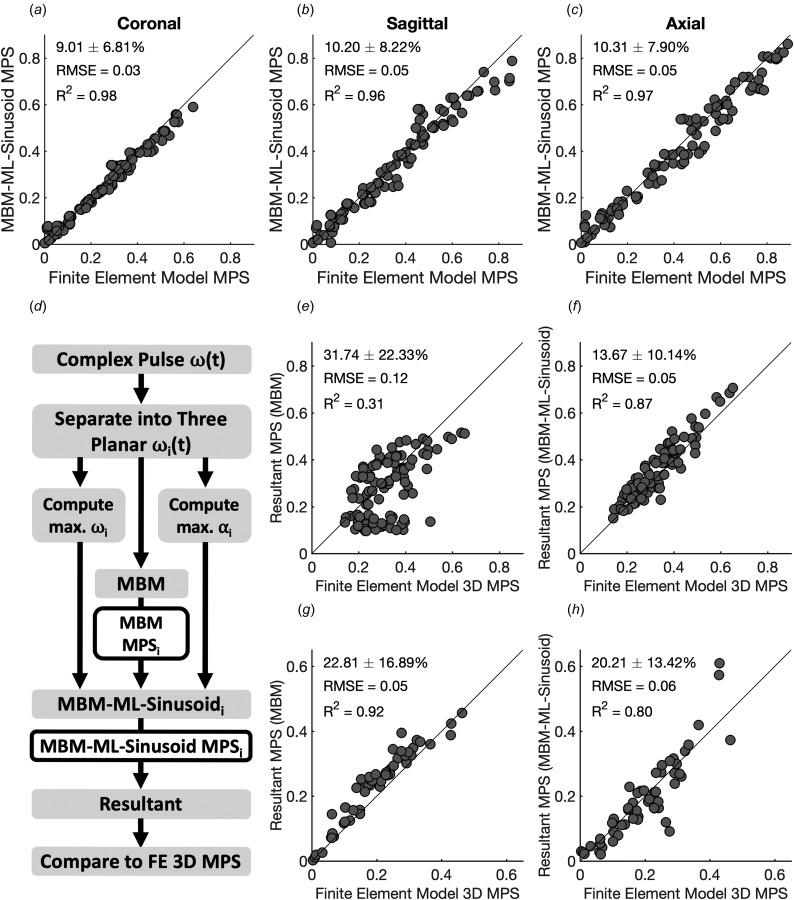
Machine learning assists MBM predictions of MPS from simple and more complex head acceleration inputs. (a)–(c) Performance of ML-assisted MBM on planar sinusoidal impact pulses. ML models were trained to predict FEM MPS using the MBM MPS and peak velocity and acceleration from the sinusoidal impact pulse (MBM-ML-sinusoid). (d) Flow diagram for evaluating the MBM-ML-sinusoid models with acceleration inputs from helmet impact tests, where i represents each planar direction. (e) MBM without the assistance of the MBM-ML-sinusoid model underestimates strain from finite element simulations of the helmet impact tests. (f) MBM-ML-sinusoid model improves the absolute relative error by correcting maximum principal strain estimates in each plane. MBM alone (g) and MBM-ML-sinusoid (h) models were then tested on independent human impact reconstructions.